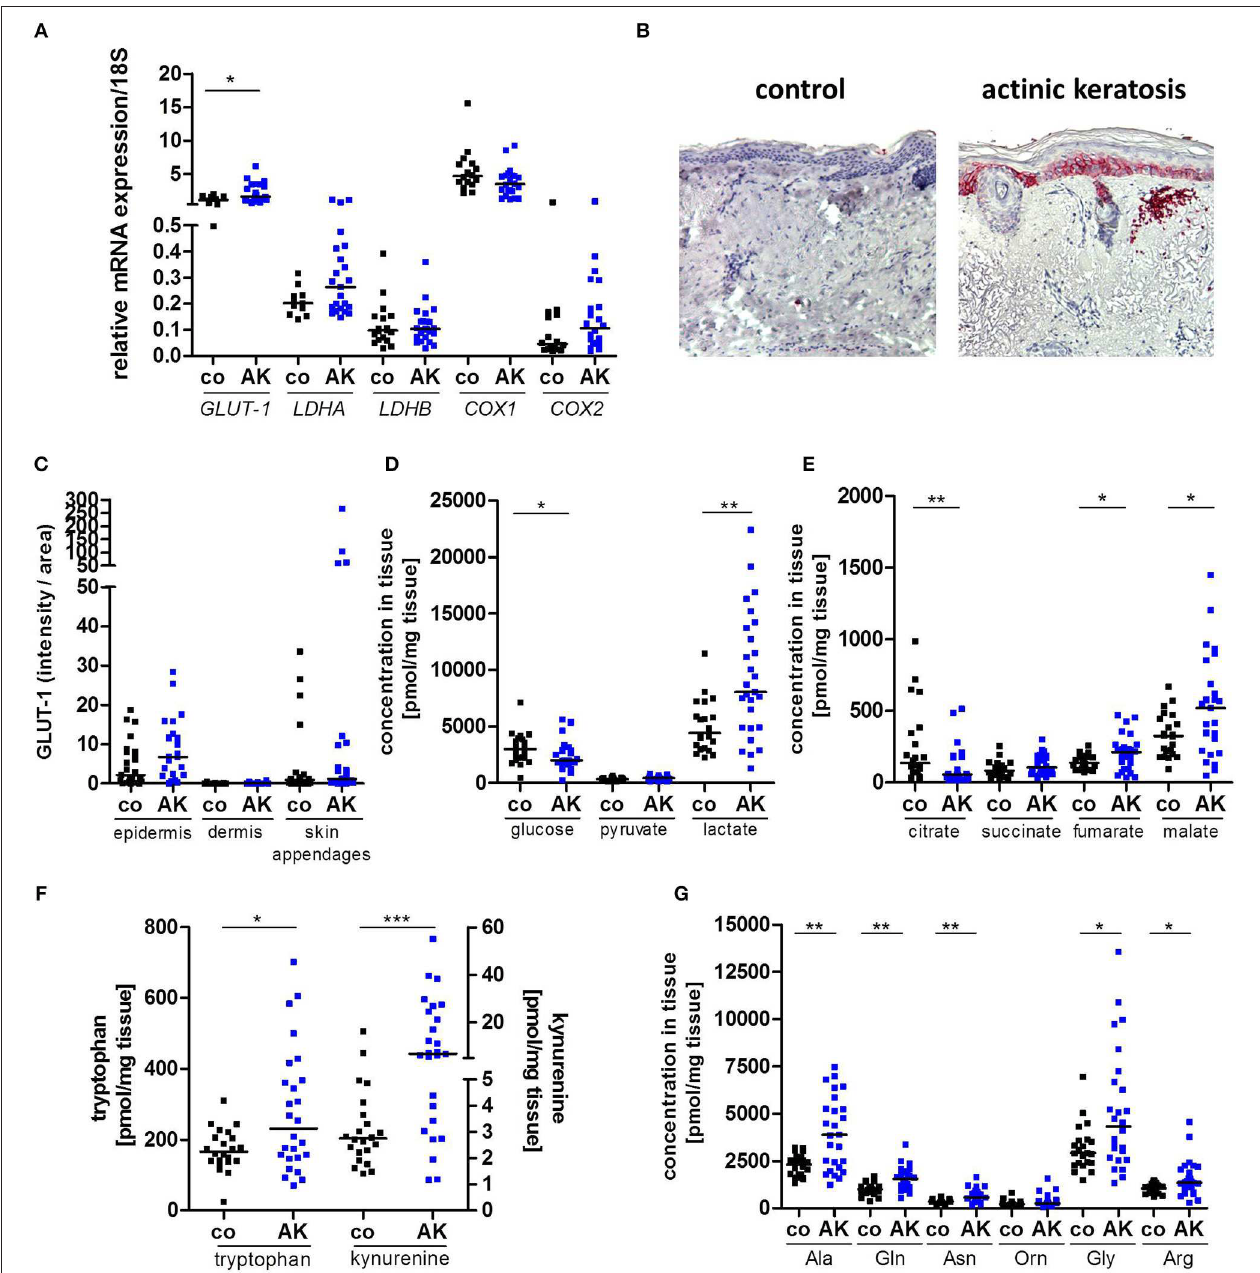
FIGURE 1 | Increased lactate and amino acid levels in actinic keratosis lesions. (A) qRT-PCR analysis of GLUT-1, LDHA, LDHB, COX1 , and COX2 gene expression in actinic keratosis lesions (AK) and control biopsies (co) of sun-exposed, untreated, healthy skin in 28 patients. (B) Representative staining of GLUT-1 in actinic keratosis lesion and control biopsy. (C) Immunohistochemical staining of GLUT-1 in epidermis, dermis and skin appendages in actinic keratosis lesions and control biopsies. The selected pixels of the evaluated images were expressed as the percentage of the total area. (D–G) Determination of intratumor metabolite levels by mass spectrometry. The dark line indicates the median. * p < 0.05, ** p < 0.01, *** p < 0.001 (Mann-Whitney test). Ala, alanine; Gln, glutamine; Asn, asparagine; Orn, ornithine; Gly, glycine; Arg, arginine.